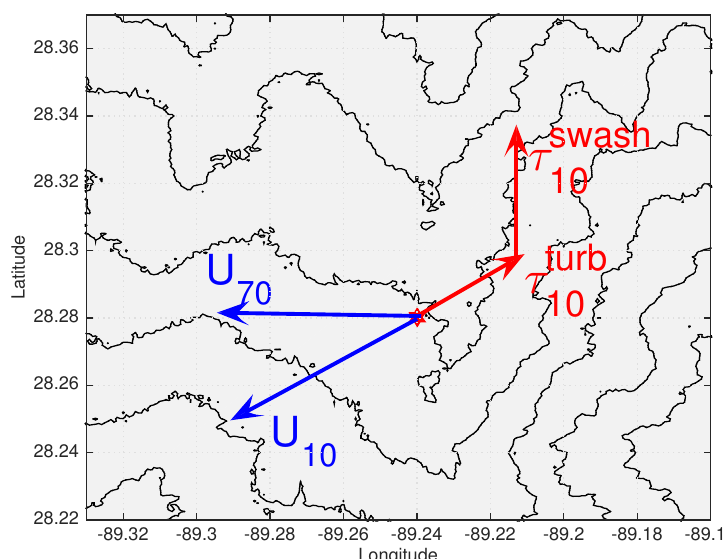
Figure 17. Horizontal velocity vectors at 10 and 70 m H ab (blues, U 10 and U 70 ) and vertical stress estimates (reds) at 10 m H ab . The mooring location at 825 m water depth serves as the origin for the vectors and is denoted by a red pentagram. Bathymetry contours are at 50 m intervals. The stress vector is composed of turbulent contributions nearly antiparallel to the 10 m horizontal velocity ( τ turb ) and a northward directed contribution from swash frequencies ( τ swash 10